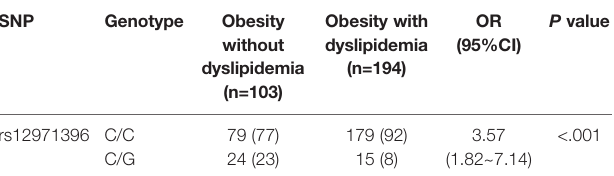
TABLE 3 | Genotypic frequencies between obesity with/without dyslipidemia.